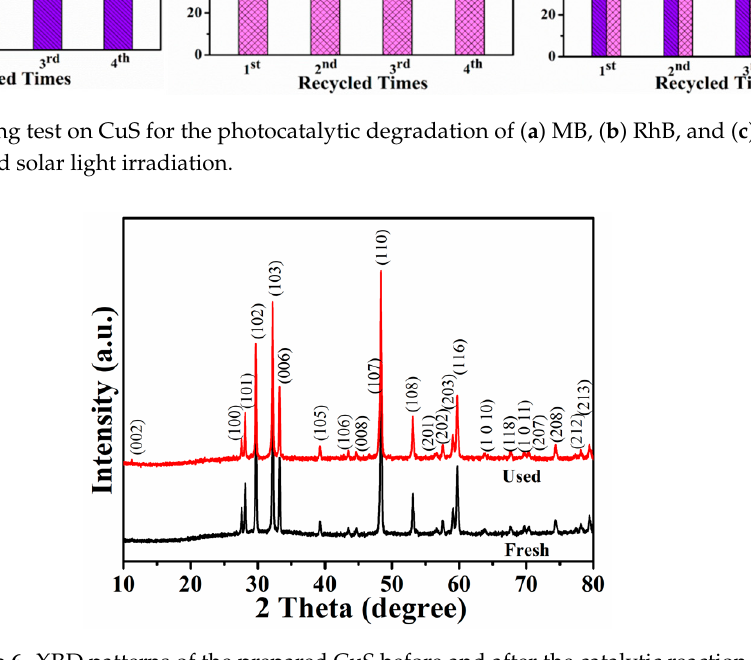
Figure 6. XRD patterns of the prepared CuS before and after the catalytic reaction.